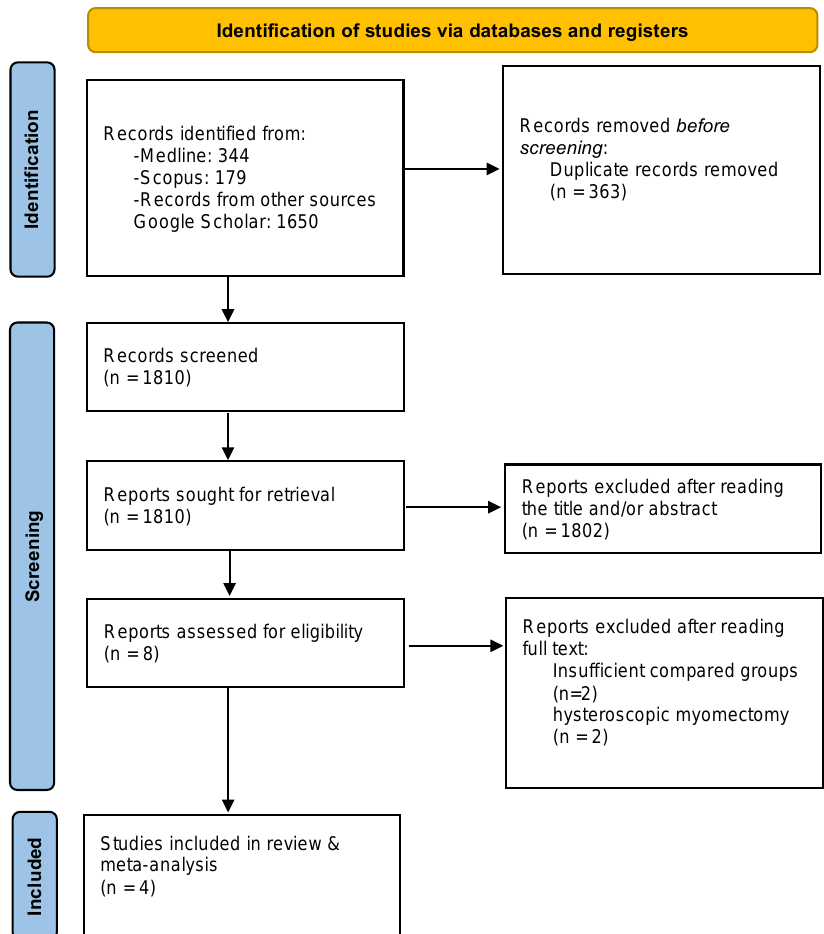
Figure 1. Search flow diagram .